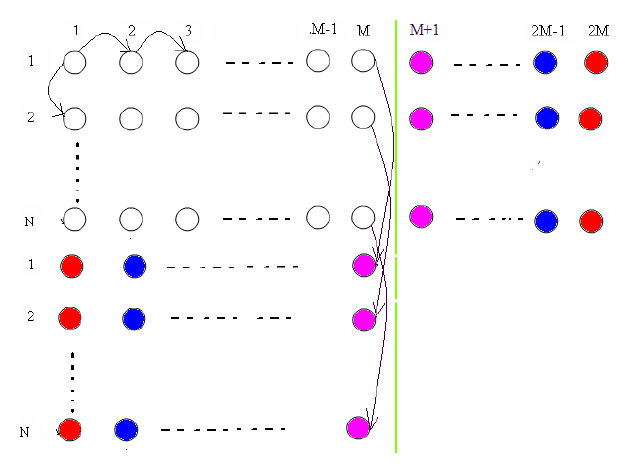
Fig. 2. The electrons moving in a Mobius